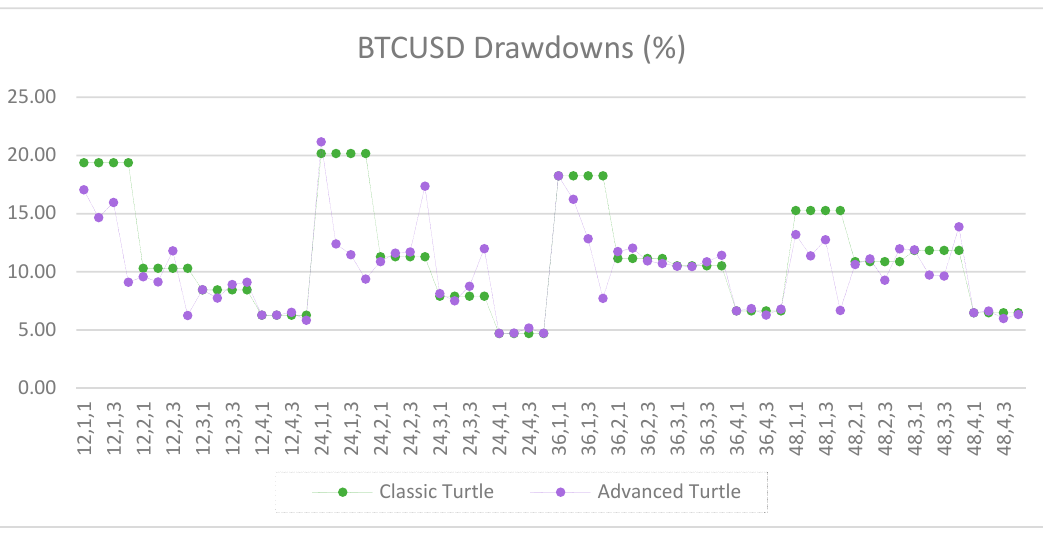
Figure A32. Drawdowns of BTCUSD as percentage of equity between the classic and the advanced Turtle systems for every combination of N, X, Y for the medium parameters (40, 80).